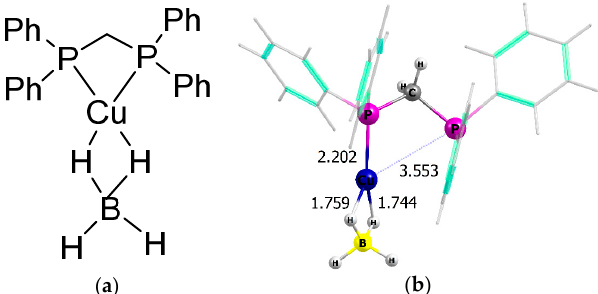
Figure 5. The tentative structure of ( η 2 -dppm)Cu( η 2 -BH 4 ) monomer ( a ) and its M06-optimized geometry ( b ).